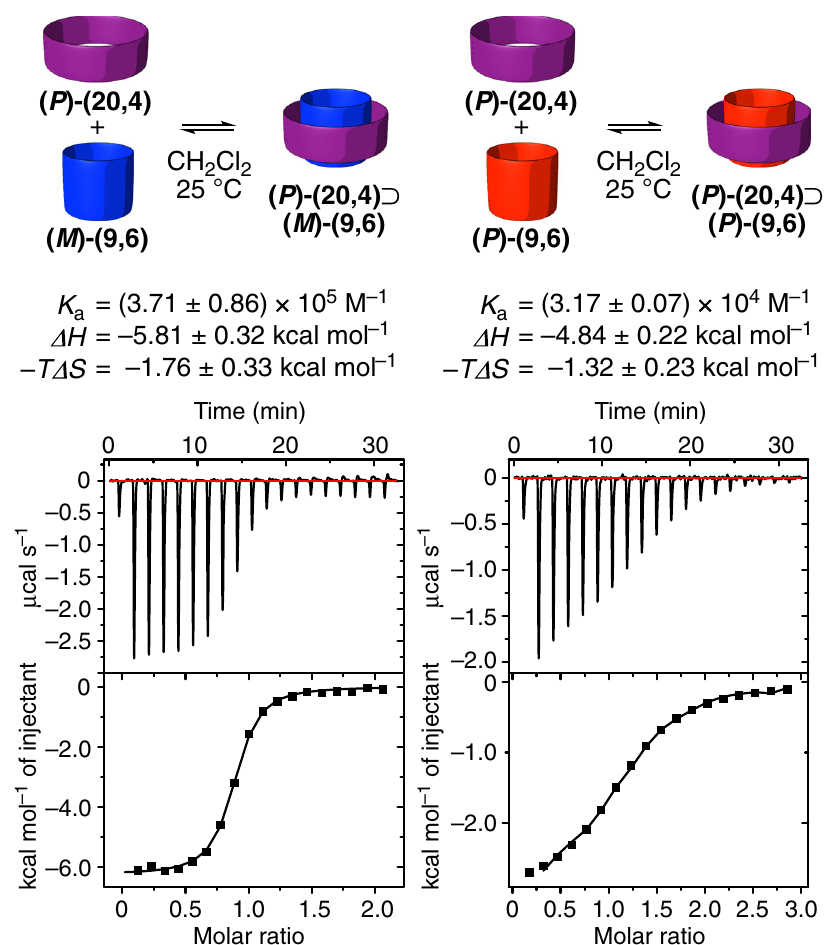
Fig. 5 Spontaneous assembly of i-DWNT complexes. Thermodynamic parameters and titration data of ITC analyses are